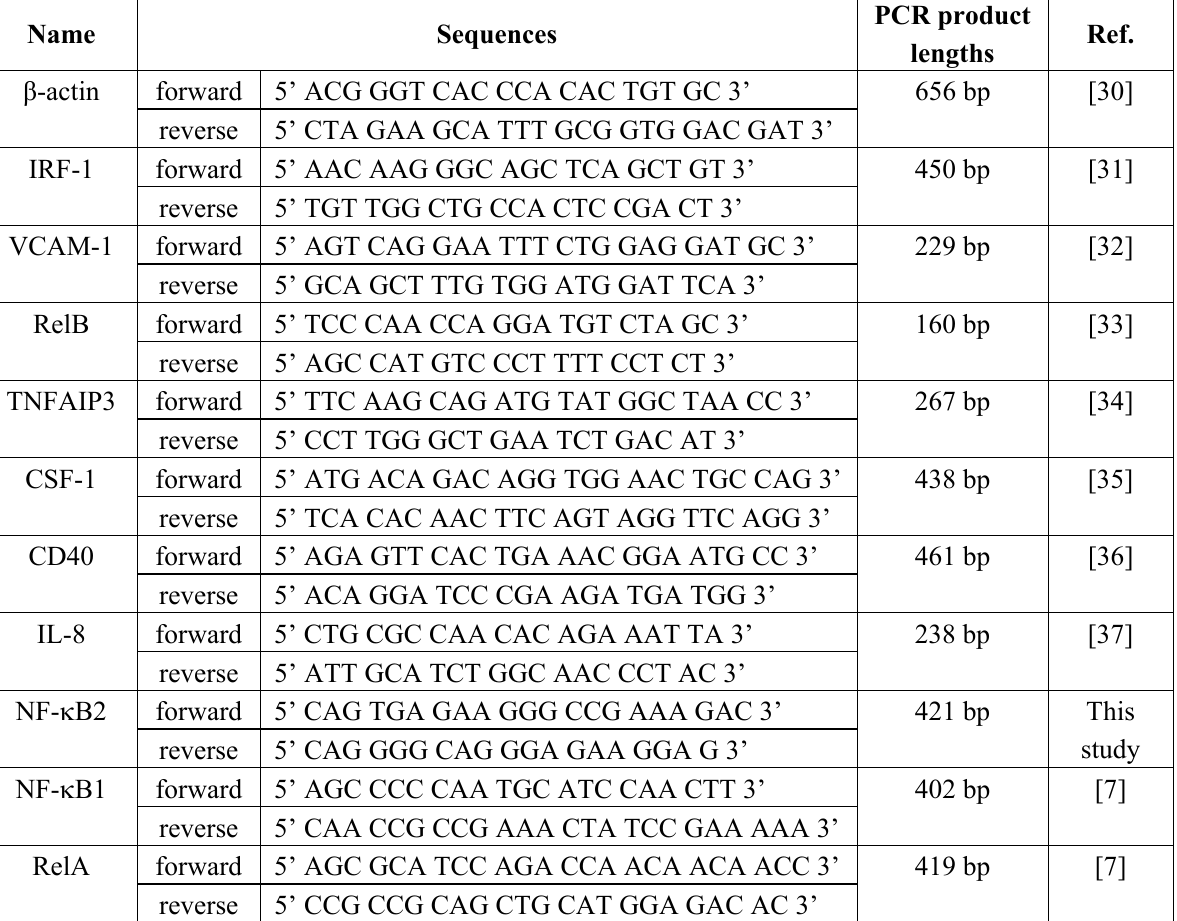
Table 1. Specific nucleotide primer used in